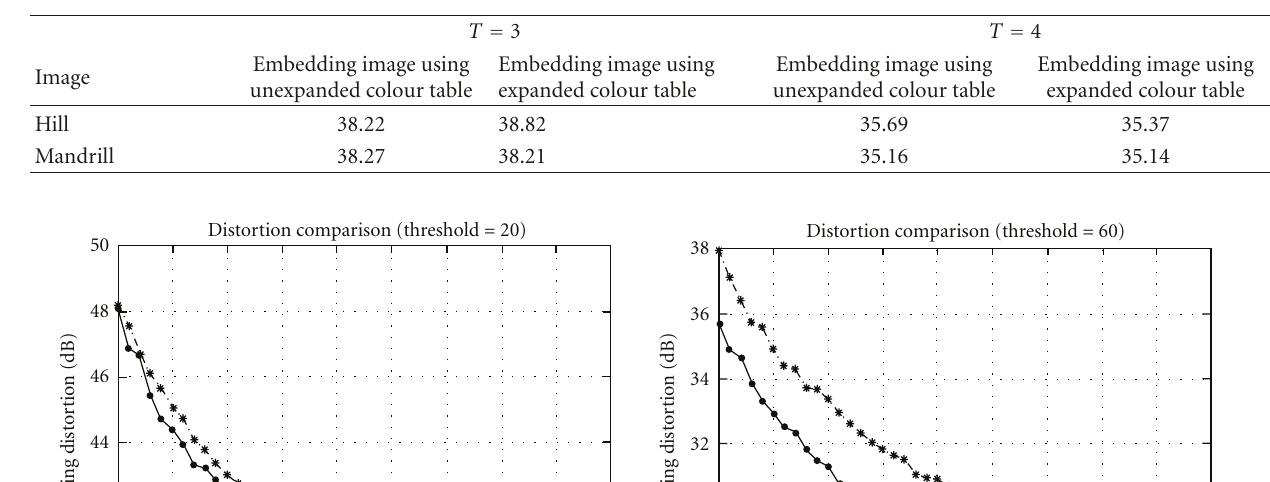
Table 4: Embedding distortion in terms of PSNR (dB) before and after clustering.